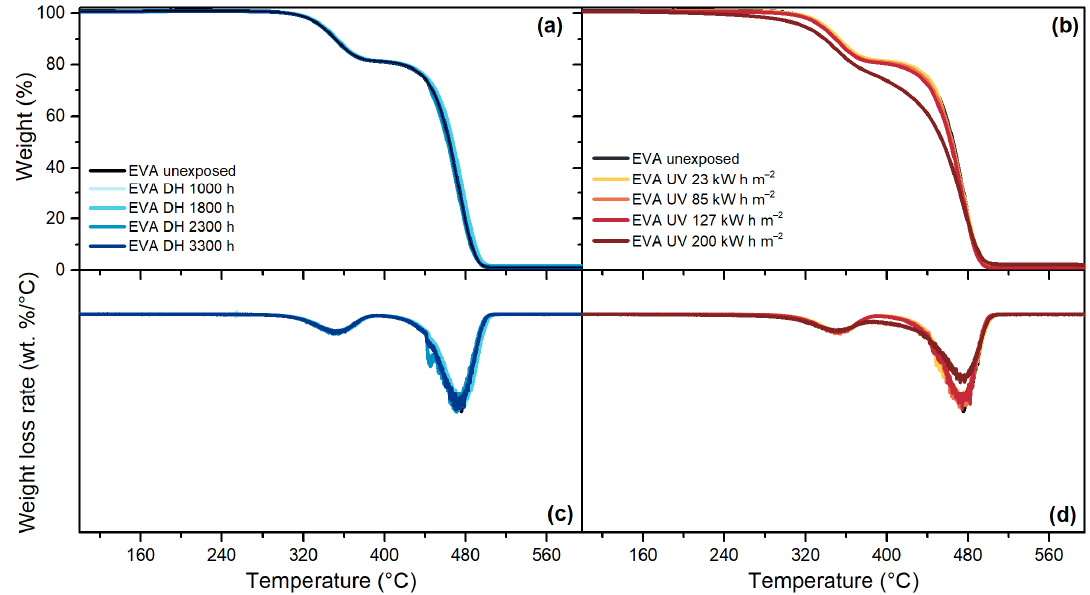
Figure 12. Residual weight over temperature during Thermogravimetric Analysis (TGA) measurements of EVA after the exposure to DH test ( a ). Residual weight over temperature during TGA measurements of EVA after the exposure to UV test ( b ). Weight loss rate over temperature of EVA samples exposed to DH test ( c ). Weight loss rate over temperature of EVA samples exposed to DH test ( d ).